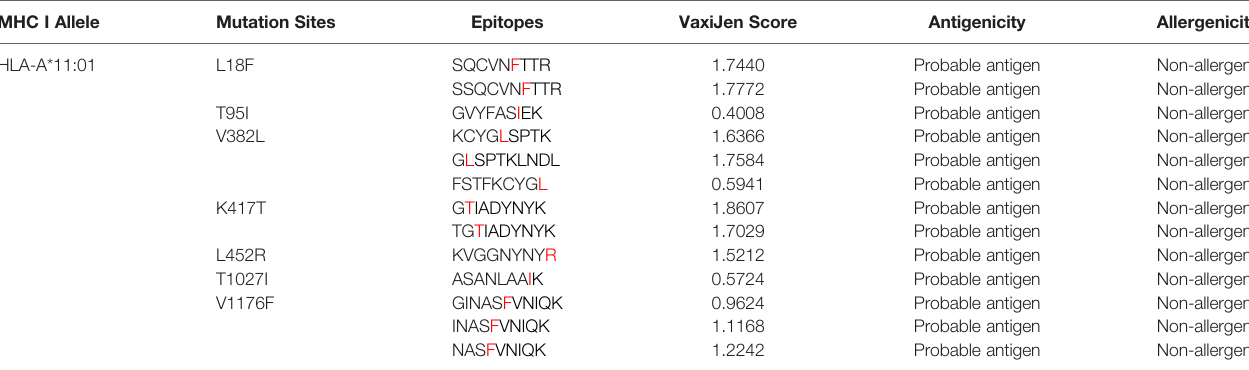
TABLE 1 | T cell-predicted epitopes of selected mutation sites based on antigenicity and allergenicity. MHC I Allele